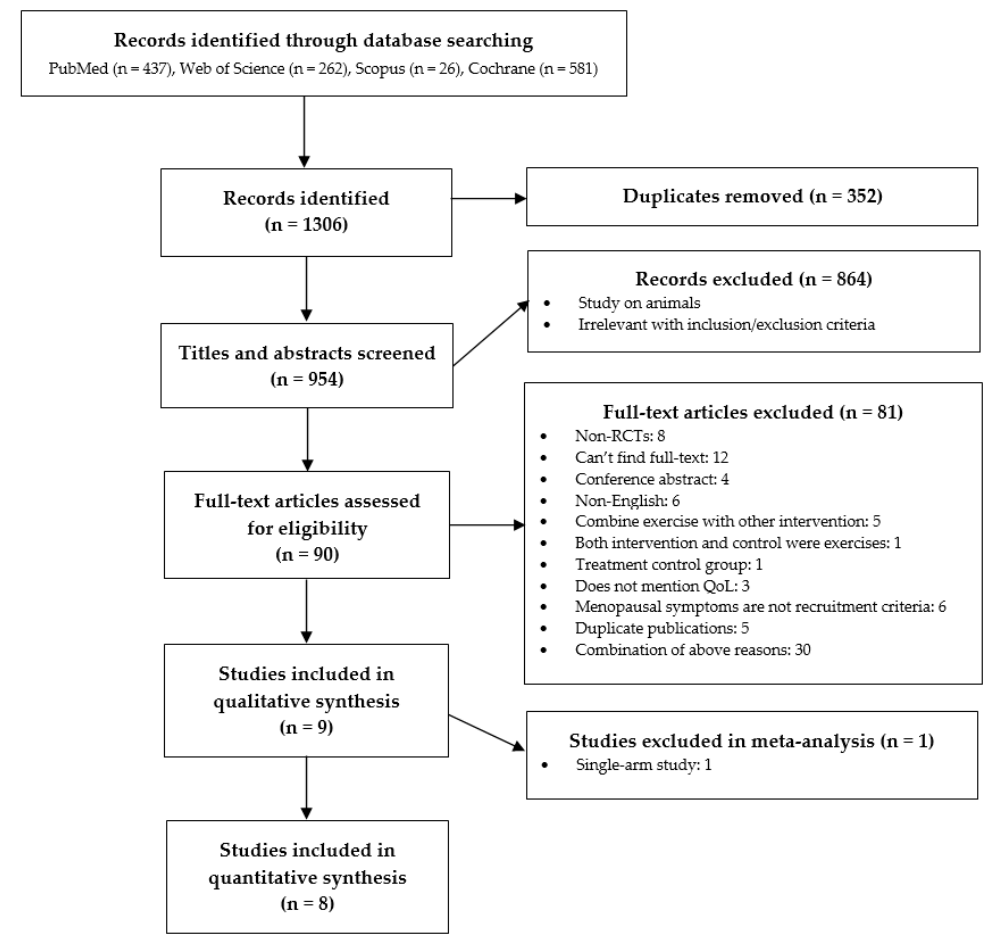
Figure 1. Flow chart of the study selection process.